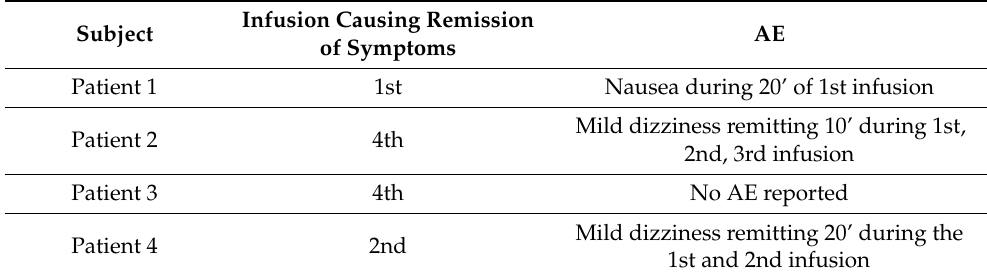
Table 3. The effects of ketamine